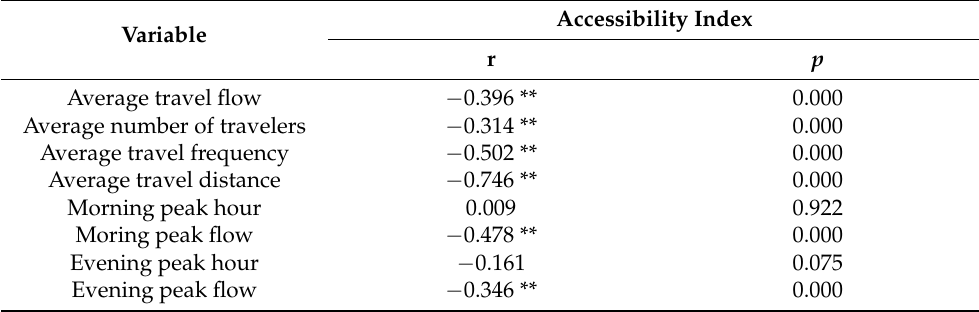
Table 8. Correlation analysis results of resident travel characteristics and accessibility index in 2017.